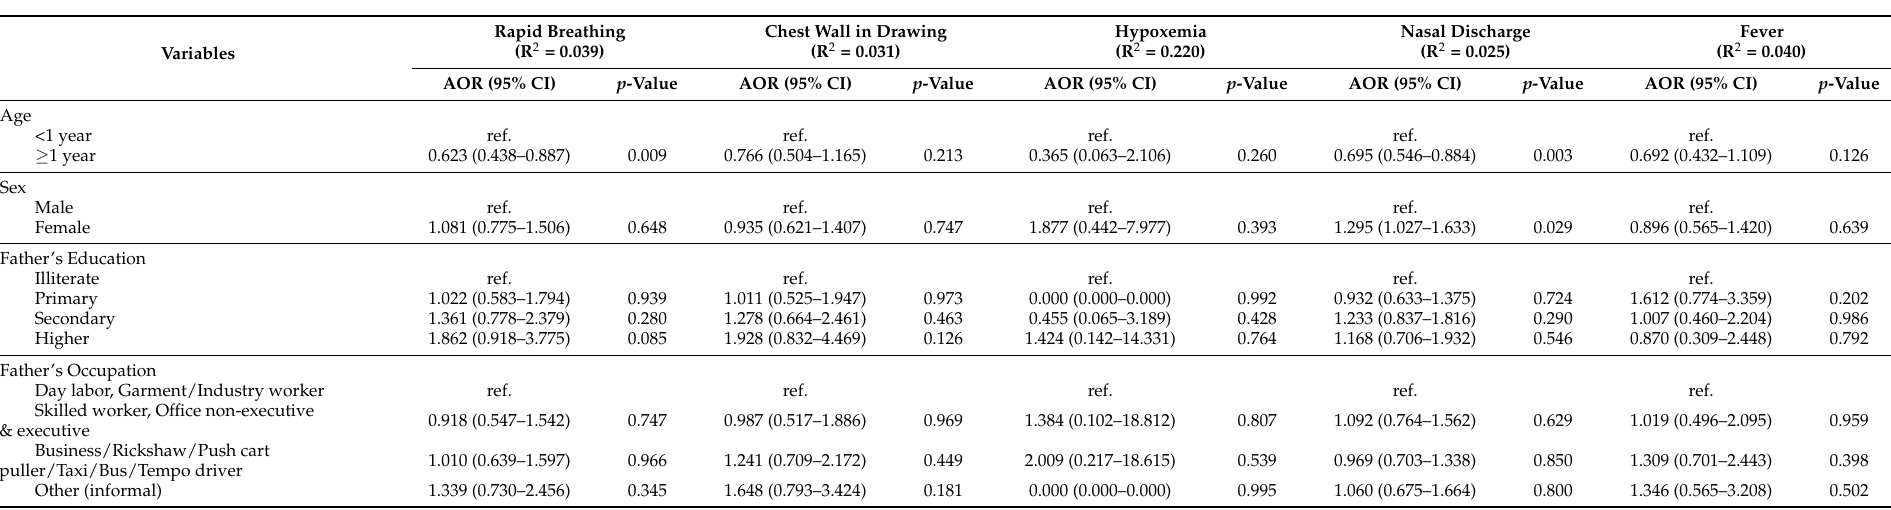
Table 3. Multivariable logistic regression model showed the association between independent (x) background factors and dependent (y) variables as different clinical